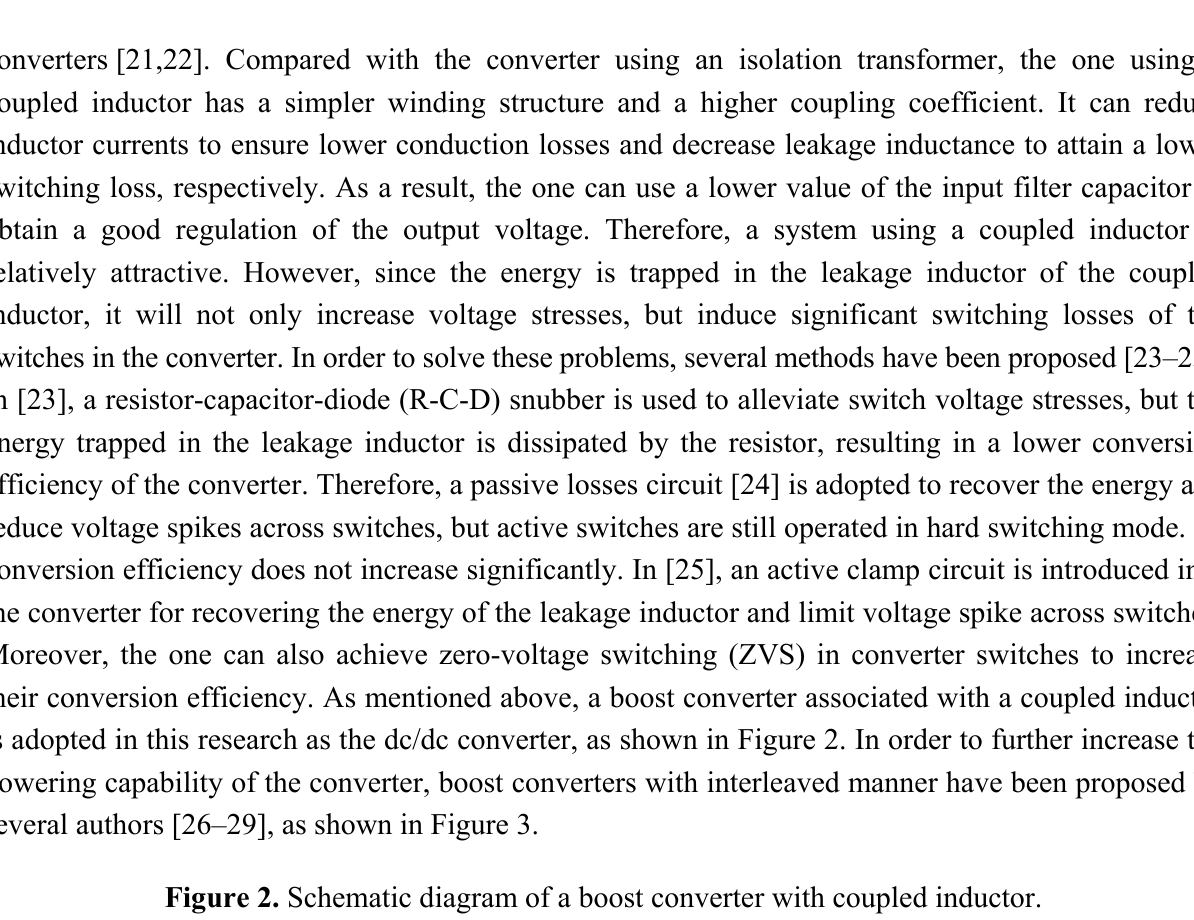
Figure 2. Schematic diagram of a boost converter with coupled inductor.